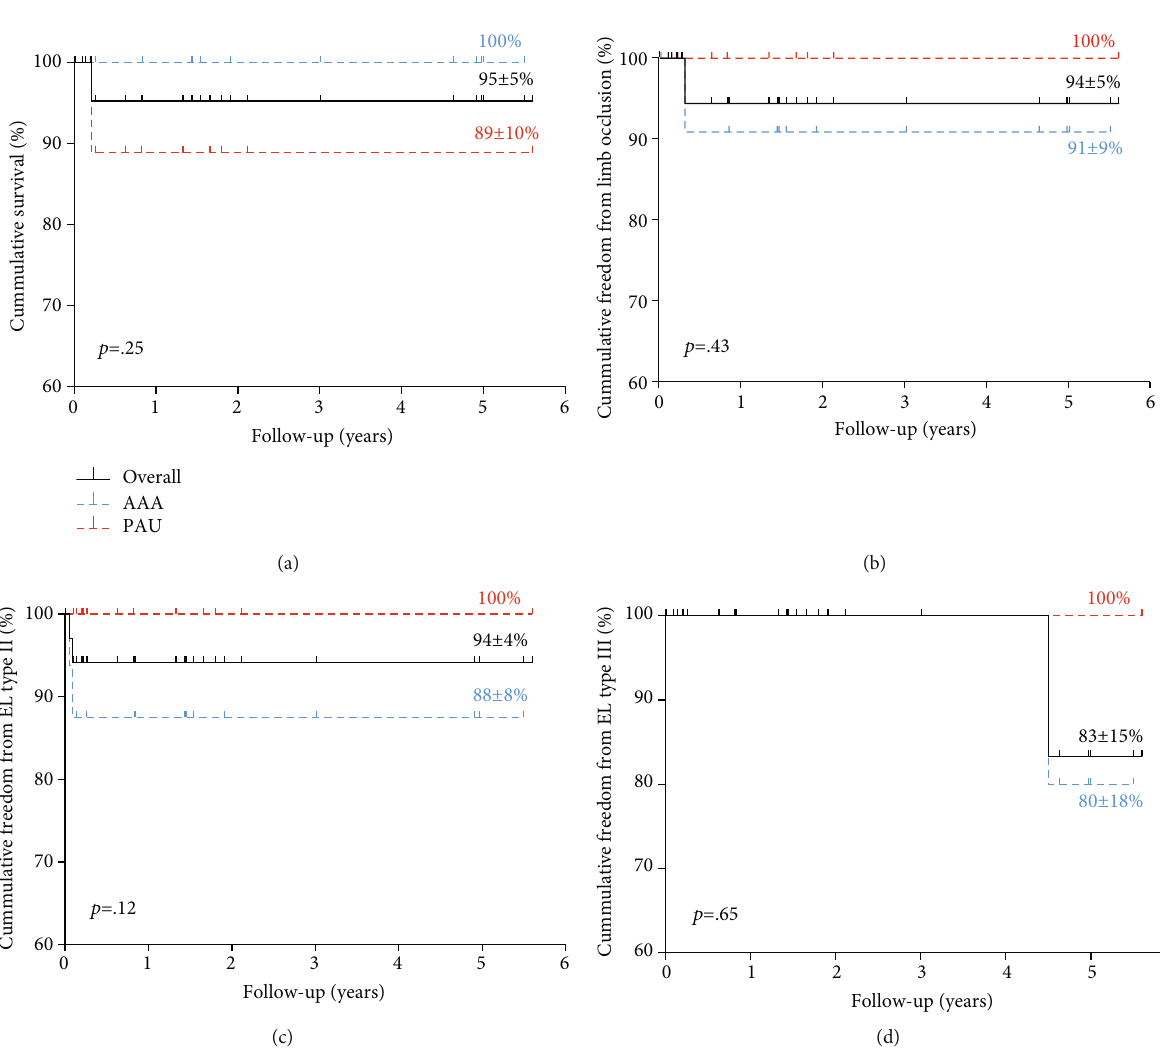
Figure 2: Kaplan – Meier estimator. Kaplan – Meier estimator with mean ± standard deviation for patient survival (a), freedom from limb occlusion (b), and freedom from type II (c) and type III (d) endoleak (EL). Patient survival was 95 ± 5 % , freedom from limb occlusion was 94 ± 5 % , "freedom from type II EL was 94 ± 4 % , and freedom from type III EL was 83 ± 15 % at the end of the follow-up after 5.6 years. The log-rank test was used to analyze di ff erences between penetrating aortic ulcer (PAU) and abdominal aortic aneurysm (AAA) patients ( n = 35